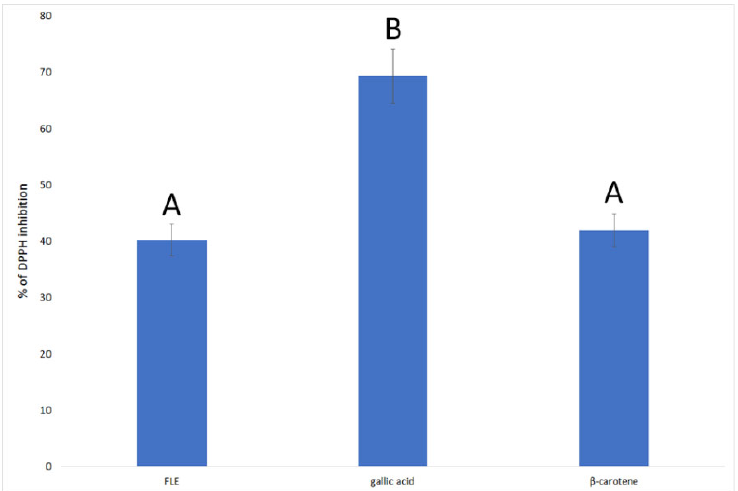
Figure 1. Antioxidant activity of F. limosus crayfish extract compared to gallic acid and β -carotene, expressed as % of DPPH inhibition. Different letters mean that the values for the bars differ statistically ( p < 0.05), N = 6.